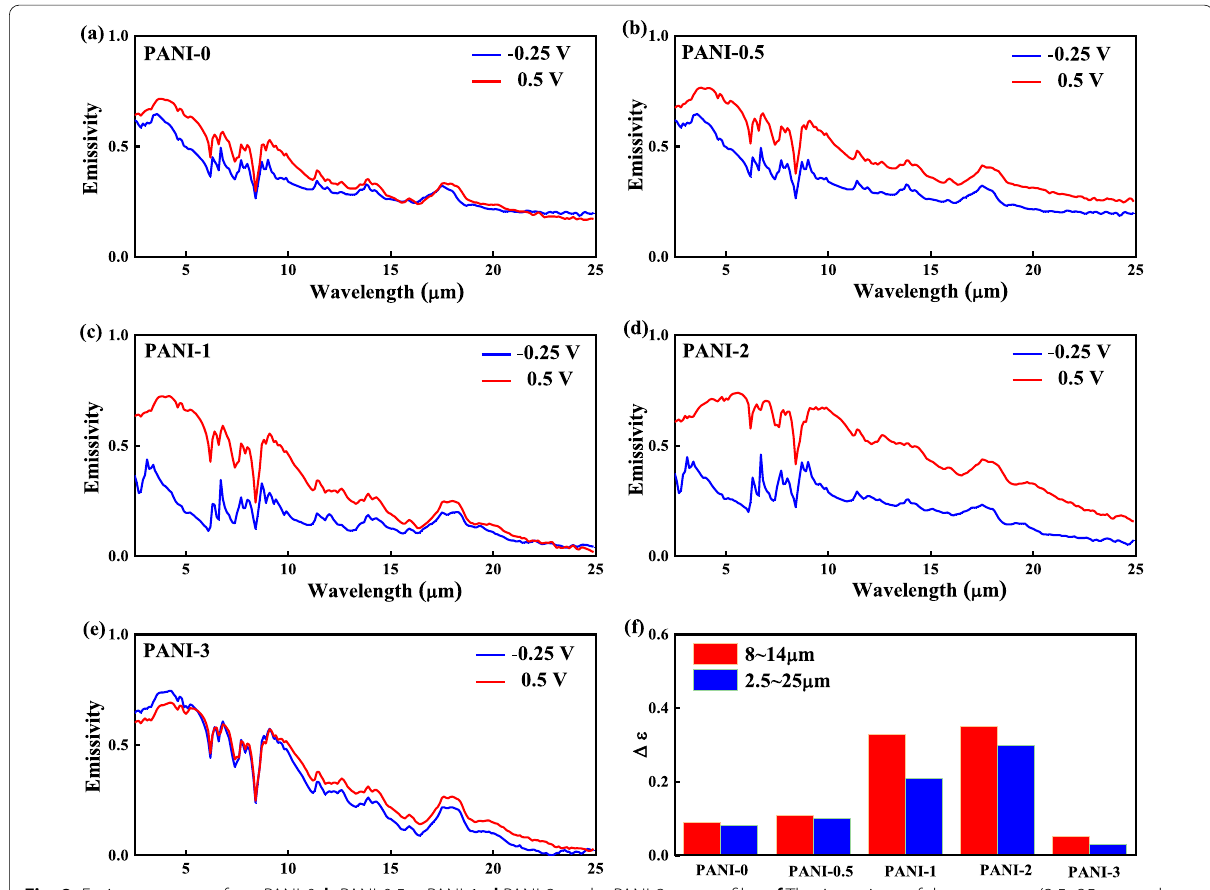
Fig. 8 Emittance curves for a PANI-0, b PANI-0.5, c PANI-1, d PANI-2, and e PANI-3 porous films. f The ∆ ε regions of the spectrum (2.5–25 µm and 8–12 µm) for Cu-doped PANI porous films at different Cu ions